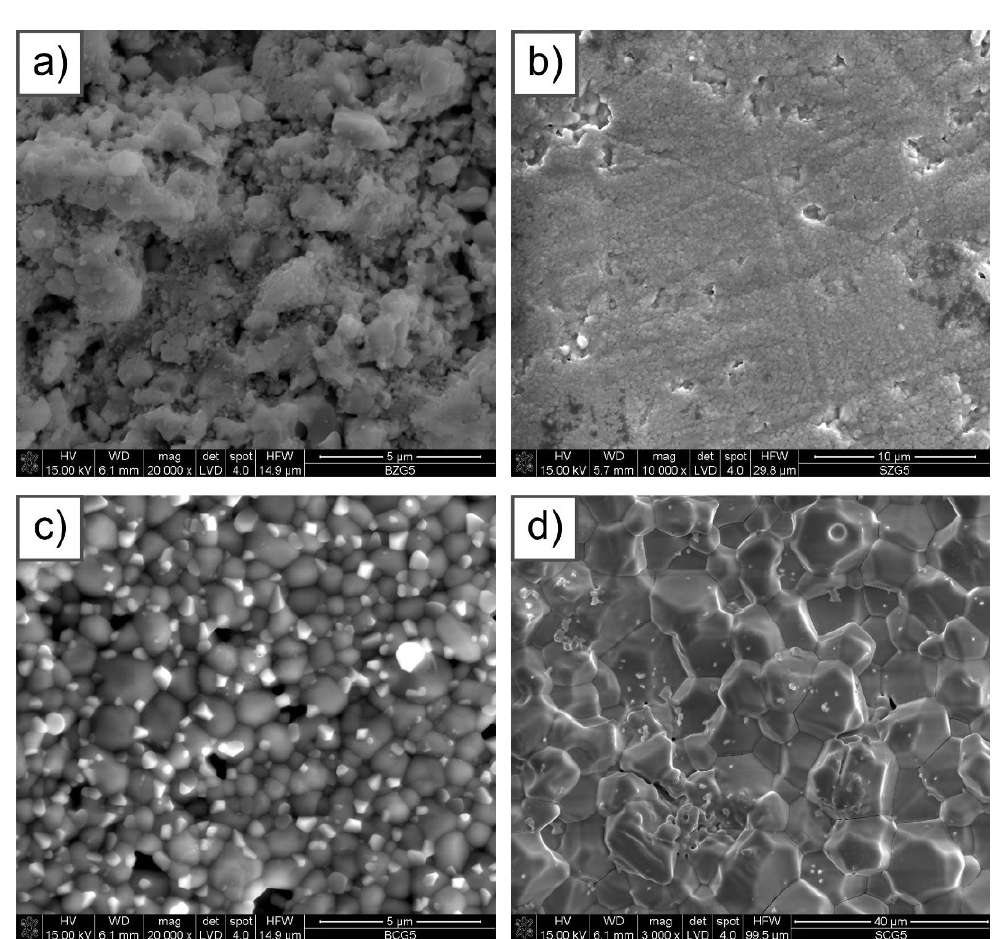
Figure 1. Scanning electron microscopy images depicting thermally etched surfaces of sintered pellets. a) BaZr c) BaCe Table 2. Relative density and average grain size of sintered pellets. Composition Sintering temperature